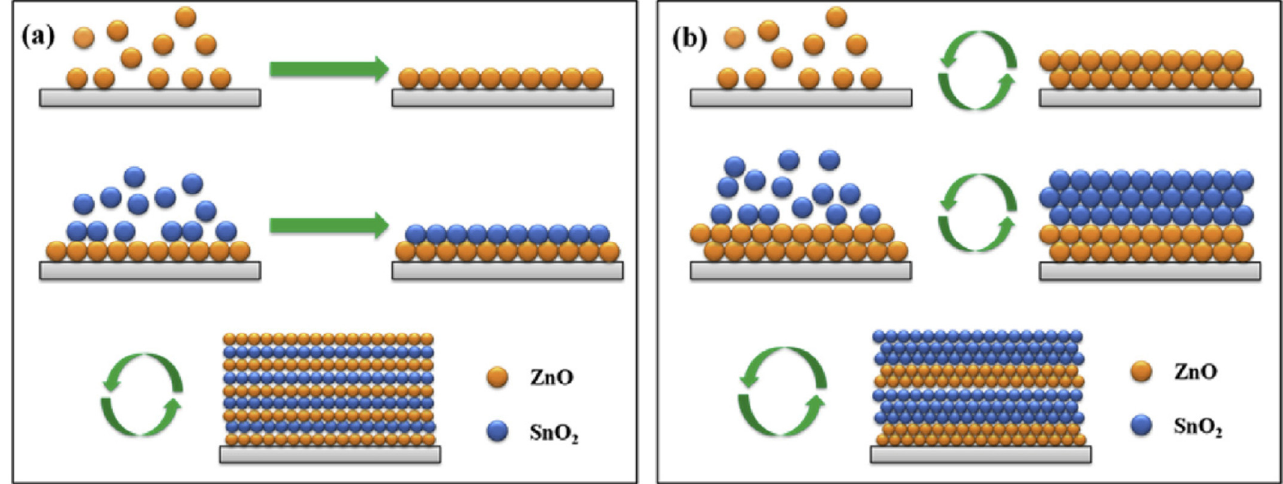
Figure 2. Synthesis of intermixed ( a ) and nanolaminated ( b ) ZnO–SnO 2 composite films by ALD. Reprinted with permission from [6]. Copyright 2019, Elsevier.